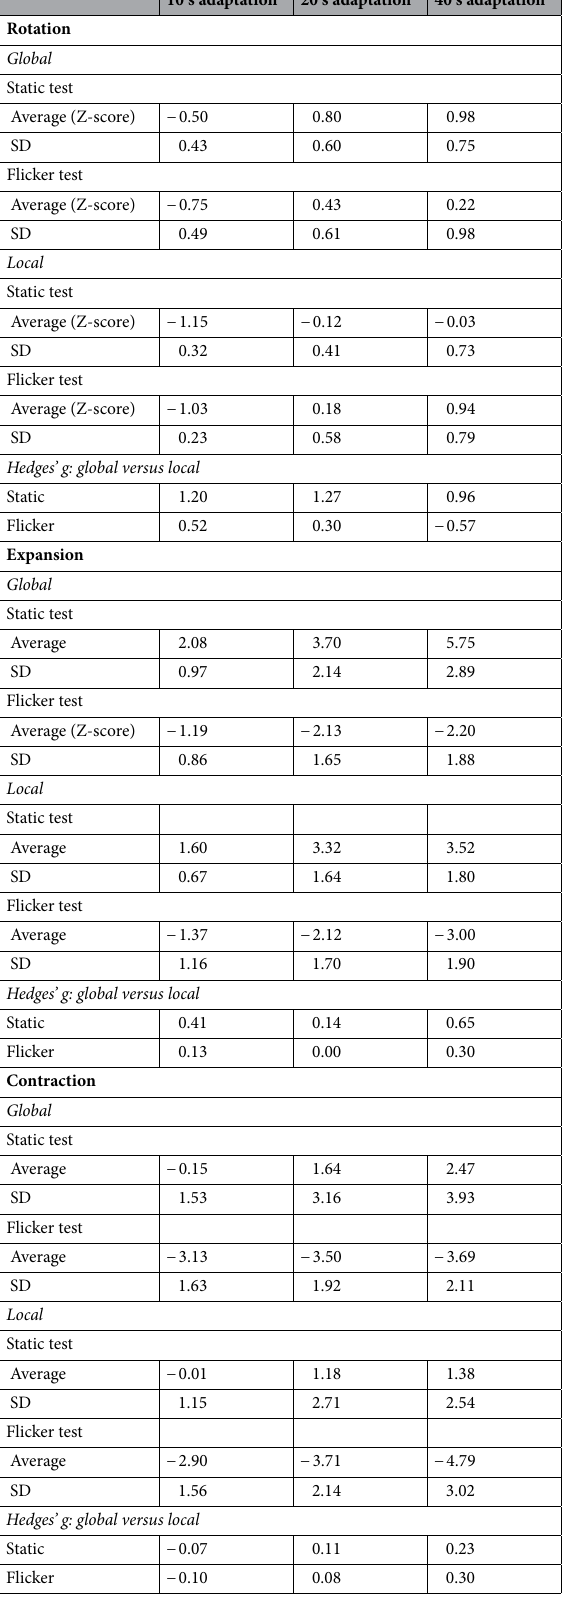
Table 3. Z-score and Hedges’ g in Experiment